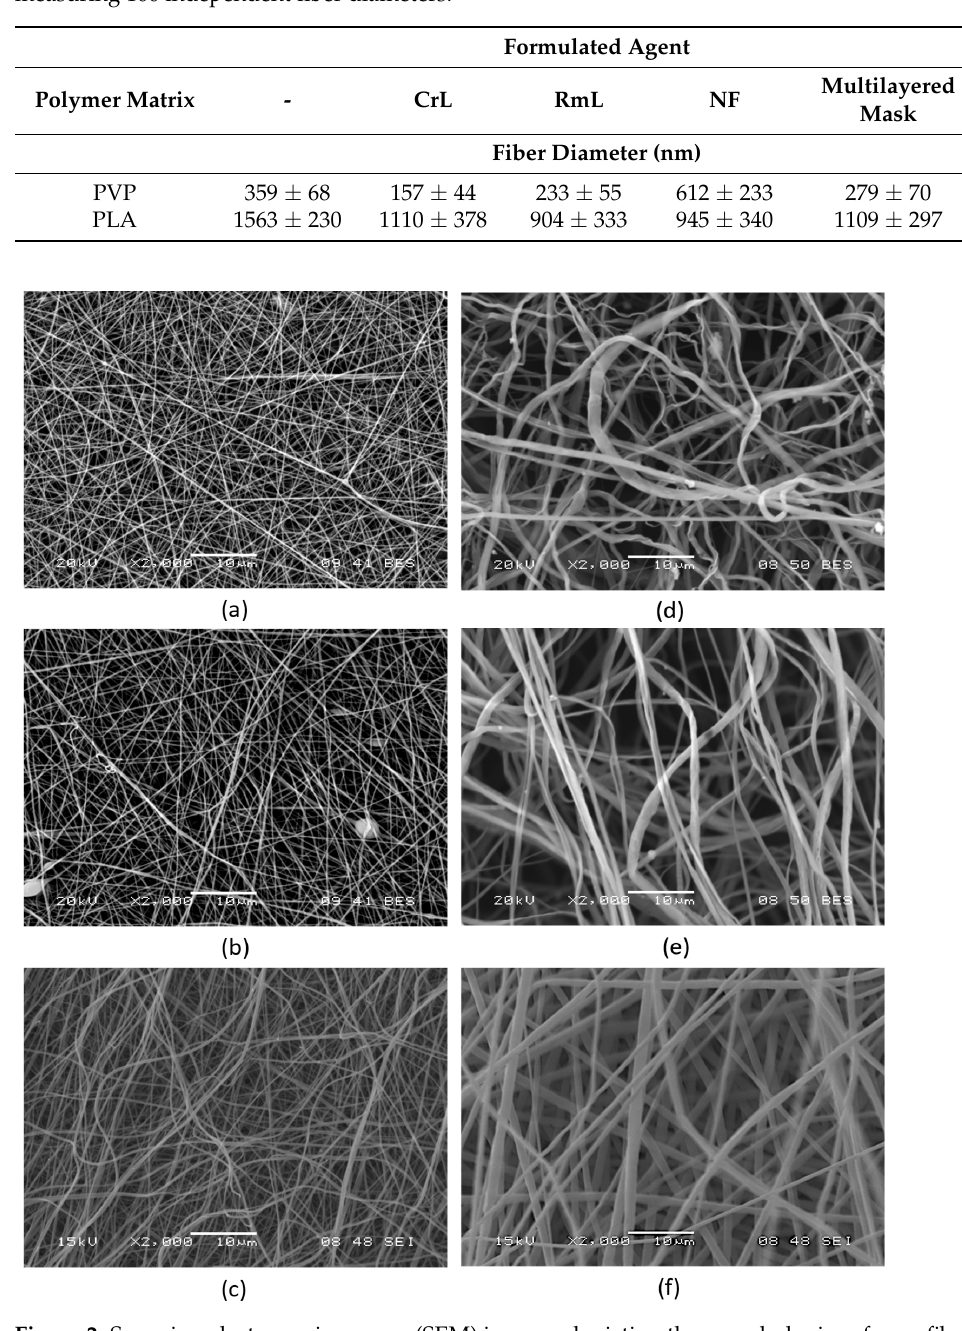
Table 1. Average fiber diameter of different polymeric (PVP or PLA) nanofibers: nanofibers without loading agent, CrL, RmL, or nadifloxacin (NF); loaded nanofibers; and multilayered mask built up from enzyme and antibiotic loaded nanofibrous layers. The diameters of the fibers were determined via software analysis of SEM images. In each case, the average fiber diameters were calculated by measuring 100 independent fiber diameters.